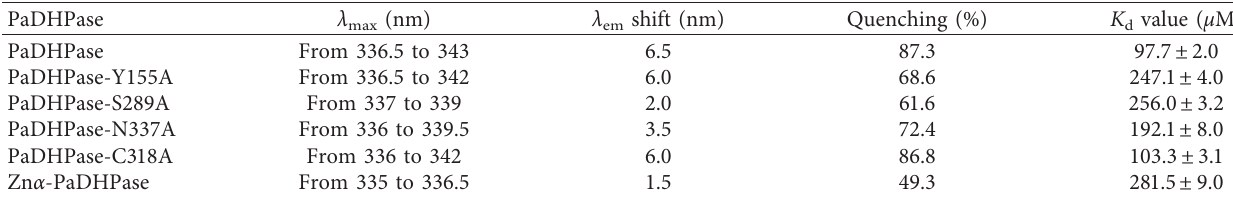
Figure 4: Fluorescence titration of PaDHPase with 5-AU. (a) The fluorescence emission spectra of PaDHPase with 5-AU of different concentrations (0–300 μ M). The decrease in intrinsic fluorescence of protein was measured at 336nm upon excitation at 279 nm with a spectrofluorimeter. The fluorescence intensity emission spectra of PaDHPase significantly quenched with 5-AU. (b) The fluorescence emission spectra of PaDHPase-Y155A with 5-AU of different concentrations (0–300 μ M). (c) The fluorescence emission spectra of PaDHPase-S289A with 5-AU. (d) The fluorescence emission spectra of PaDHPase-N337A with 5-AU. (e) The fluorescence emission spectra of PaDHPase-C318A with 5-AU. (f) The fluorescence emission spectra of Zn α -PaDHPase with 5-AU. (g) An aliquot amount of 5-AU was added to the enzyme solution for determining the K d . The K d was obtained by the equation: Δ F � Δ F max − K d ( Δ F /[5-AU]). Data points are an average of 2–3 determinations within 10% error. Table 3: Binding parameters of PaDHPase to 5-AU.